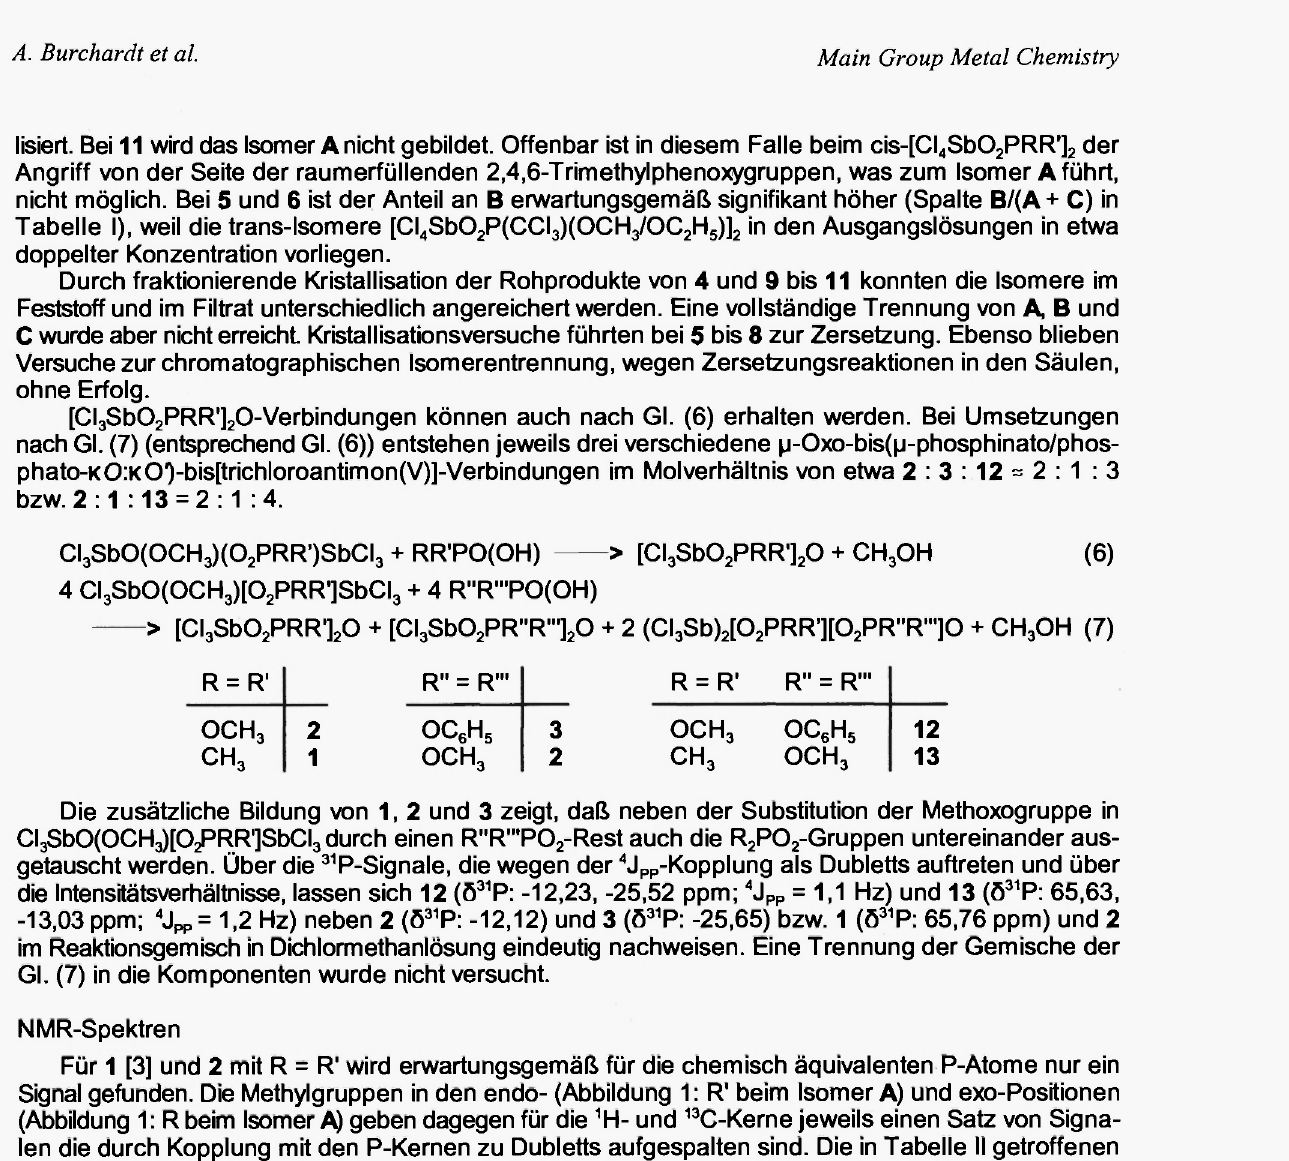
Tabelle II NMR-Daten von [C^SbO.PiCH^O (1), [CI 3 Sb0 2 P(0CH 3 )J 2 0 (2) und δ 31